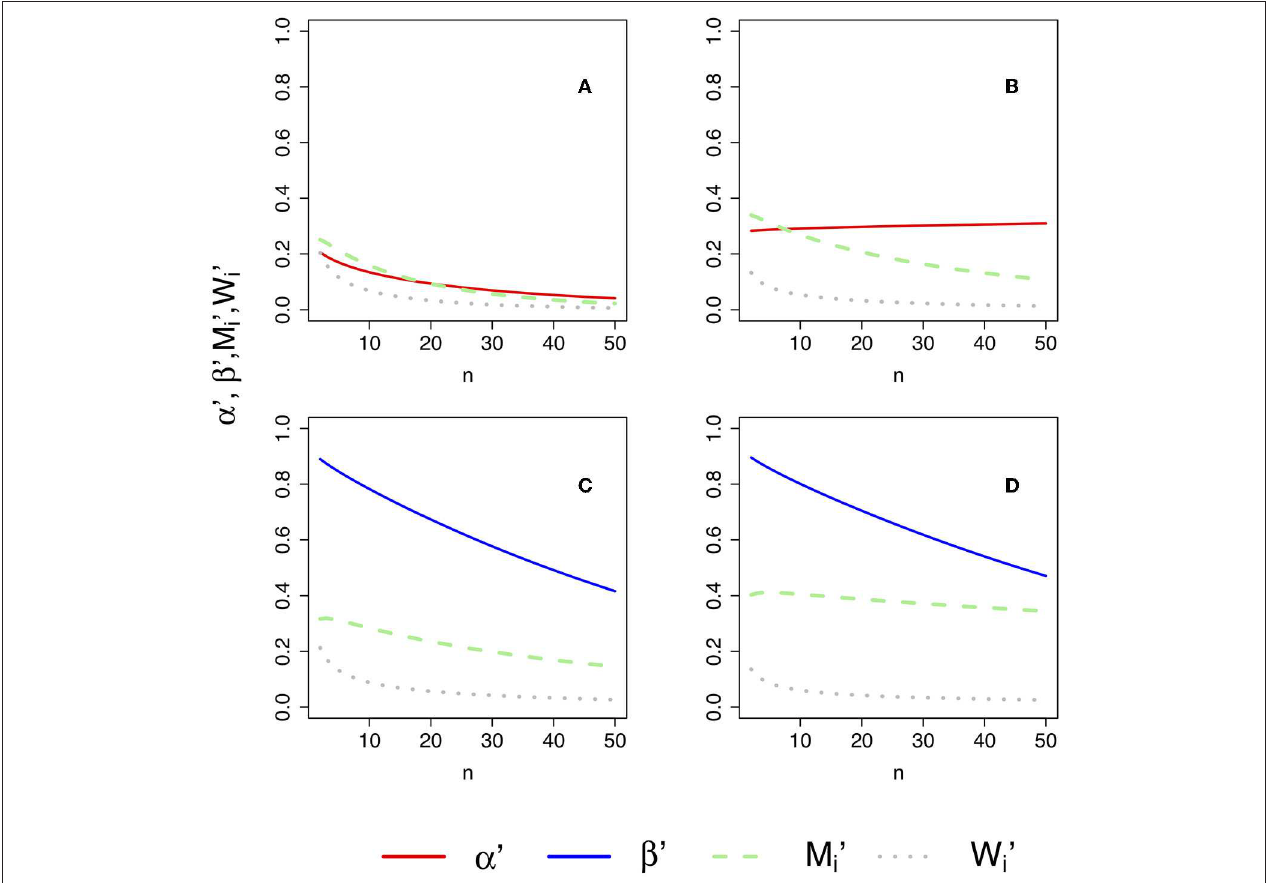
FIGURE 5 | Changes in α ′ (Equation 53), β ′ (Equation 59) and M ′ i , W i , i 1,2 (Equations 71, 72) as a function of sample size. The plot in (A–D) were computed under ′ = each of the geometries plotted in Figures 4A–D . (A) α ′ , M ′ 1 , and W ′ 1 for the models geometry in Figure 4A , where all models are aligned and model f 1 is closest to the generating process. (B) Same as in (A) but model f 1 is misaligned. C β ′ , M ′ 2 , and W ′ 2 for model geometry in Figure 4C , where model f 2 is closer to the generating process and all models are aligned. D : β ′ , M ′ 2 , and W ′ 2 for model geometry in Figure 4D , where model f 2 is closer to the generating process but model f 2 is